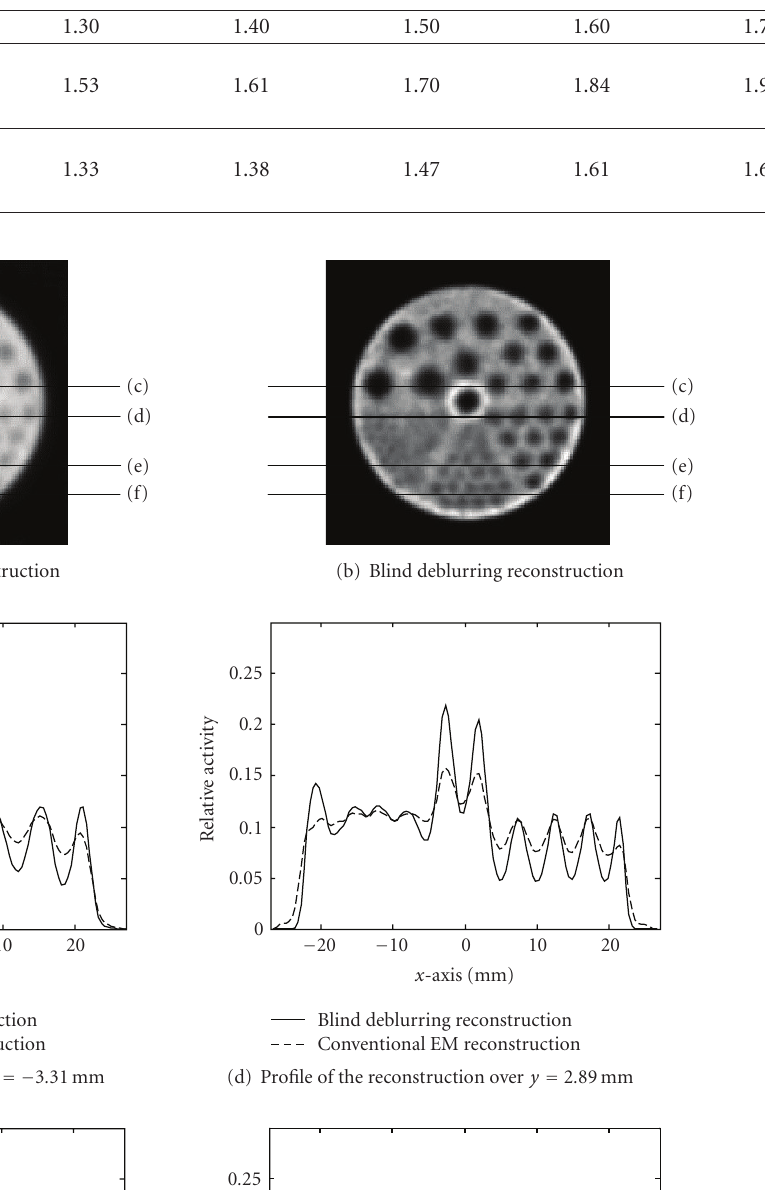
Table 1: Mean FWHM measurements for di ff erent groups of cylinders.